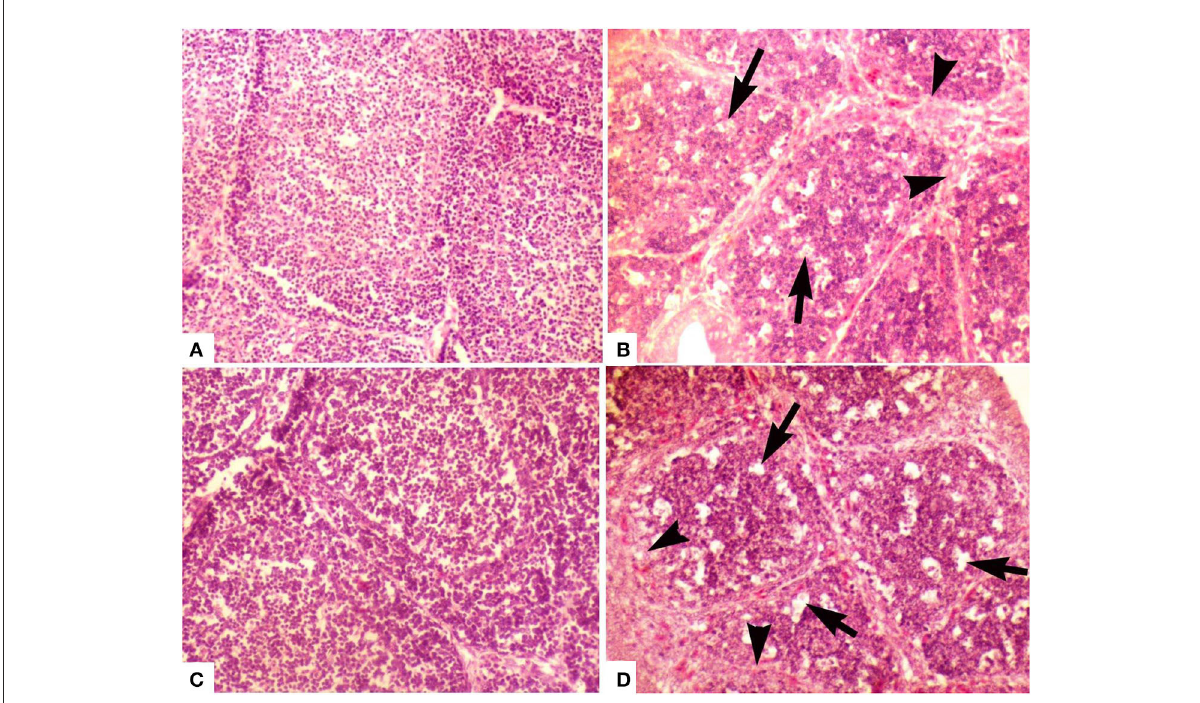
FIGURE2 Photomicrograph of bursa of Fabricius of layer chicken on day 28. (A) Developed cortex and medulla (post-hatch vaccination group D), (B) (group A in ovo 228 E) and (C) showing demarcated cortex and medulla (group B) ( in ovo Winterfield 2512: 10/3) (H&E staining at 200 × ) (D) (group C in ovo Winterfield 2512: 10/2.7) showing vacuolar degeneration (arrows), polymorphic cells in the medullary region and interfollicular connective tissue fibrosis (arrow